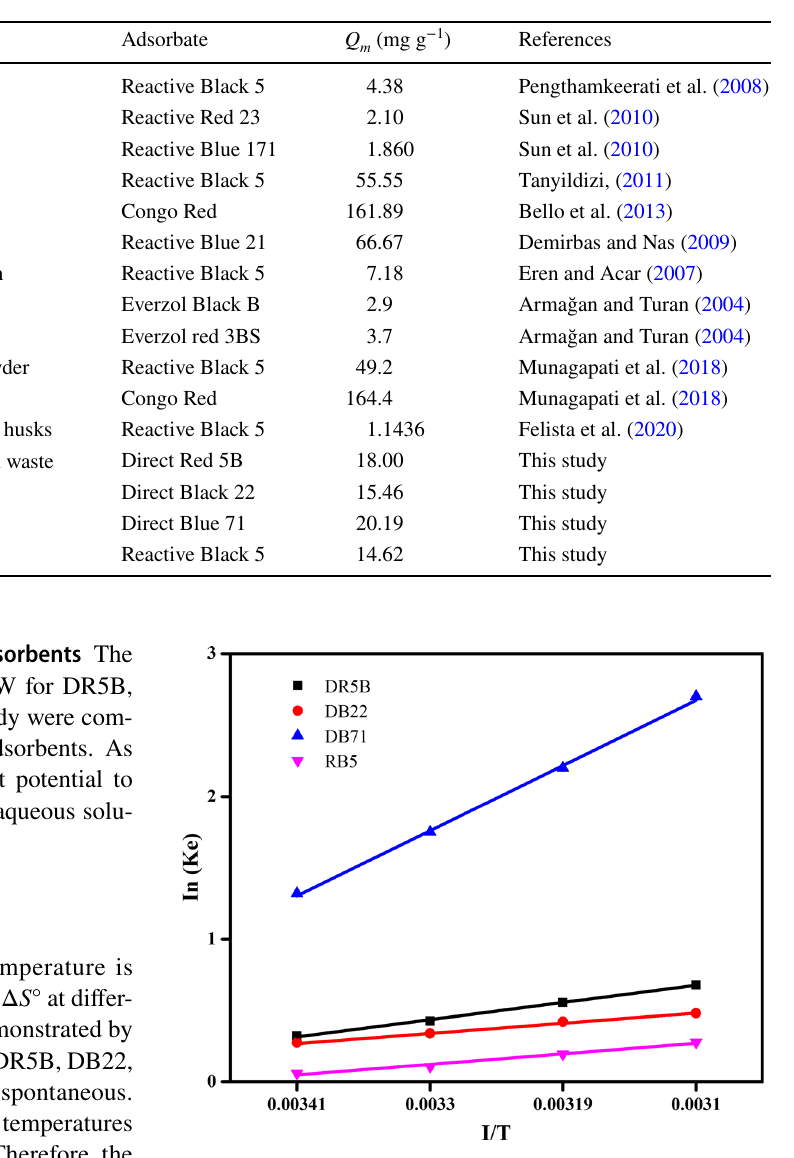
Fig. 6 Plot of In K versus 1/ T for the thermodynamic evaluation of the adsorption of DR5B, DB22, DB71, and RB5 onto spent mushroom